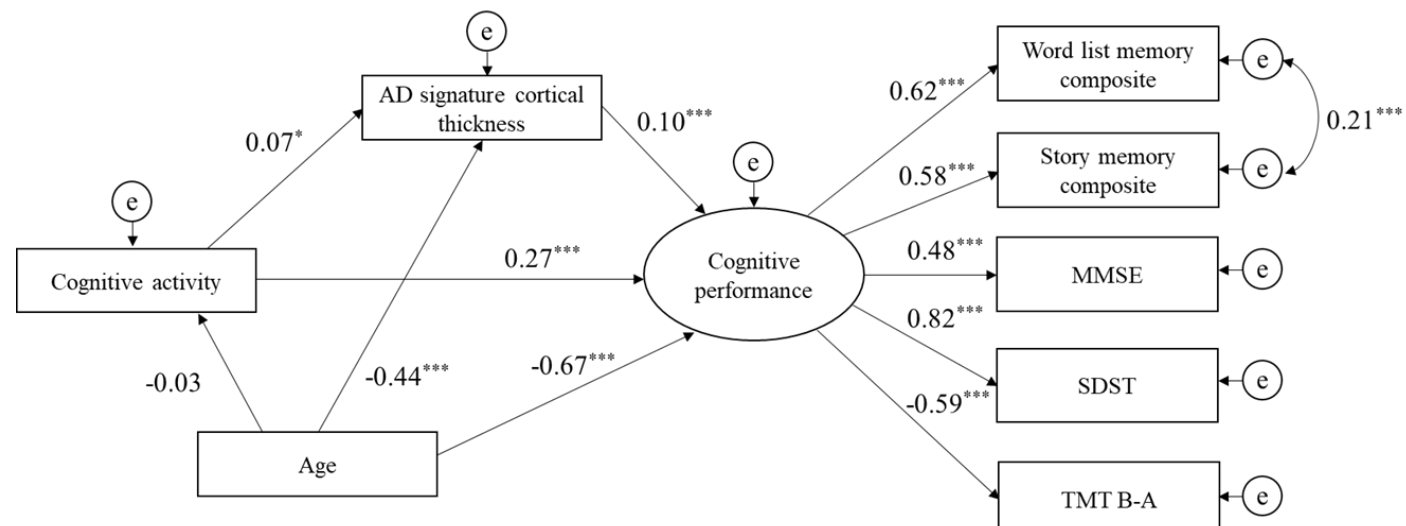
Figure 2. Structural model for associations of cognitive activity, AD signature cortical thickness, and cognitive performance. Goodness of fit index = 0.98, comparative fit index = 0.97, root mean square error of approximation = 0.06. e, error term; MMSE, Mini-Mental State Examination; SDST, Symbol Digit Substitution Test; TMT B-A, Trail Making Test part B minus part A. * p < 0.05, ** p < 0.01, *** p < 0.001.